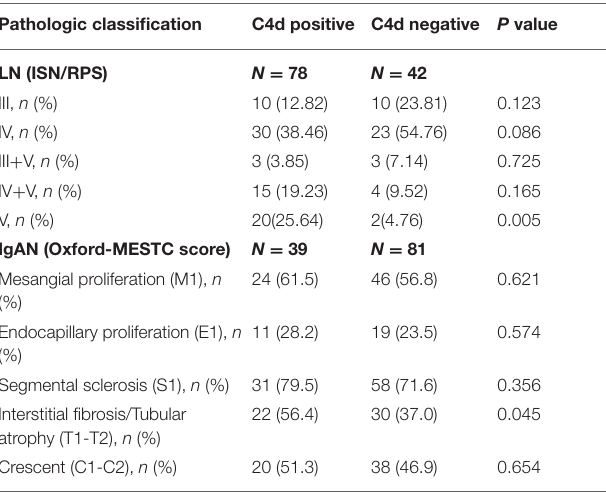
TABLE 3 | Relationship between renal C4d deposition with the ISN/RPS pathologic classes for LN and the Oxford classification for IgAN. Pathologic